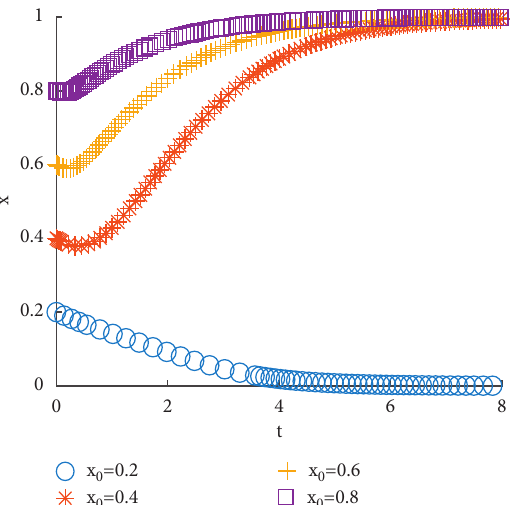
Figure 4: The comparison diagram on sensitivity analysis of equilibrium points. Take initial values for all parameters.